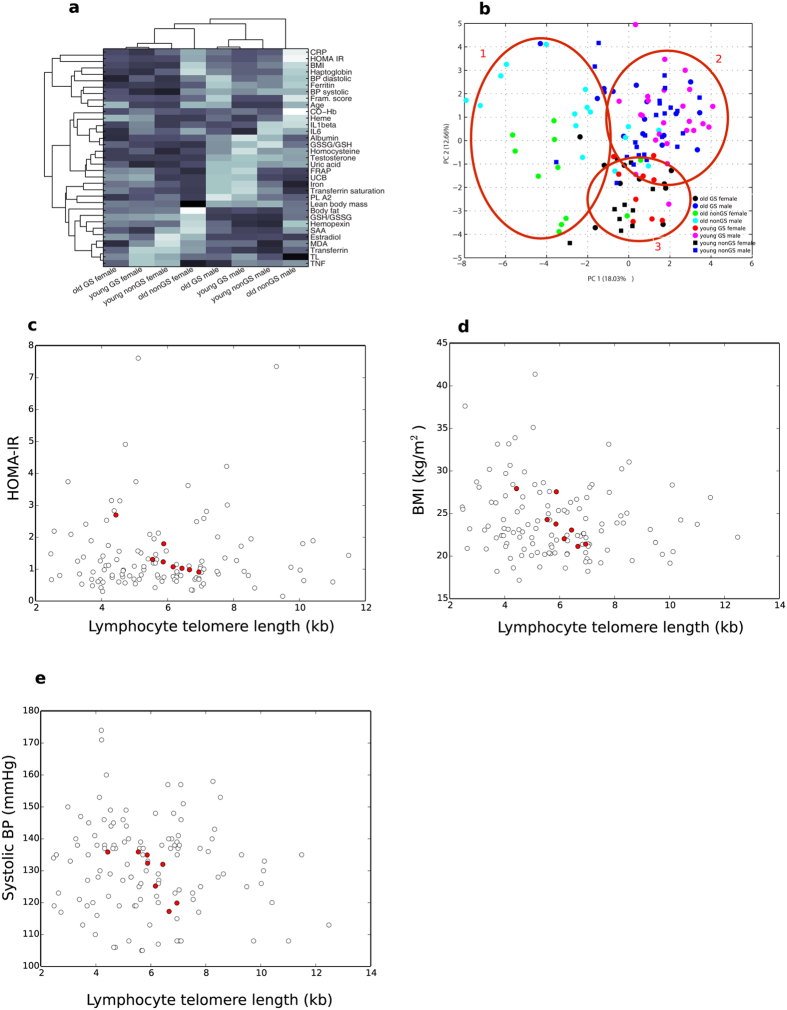
COVAIN analyses revealed distinct clustering among the eight study groups, divided according to age, gender and GS phenotype.Males and females form two distinct clusters with a small distance between “young” (<35 years old) individuals and “old” (≥35 years old) GS individuals, whereas there is a clearly greater distance of “old” control subjects. (a) Heat map shows clustering of groups and contributing variables. For individual differences in variables between groups refer to supplementary Tables S1 and S2. (b) Principal components analysis contribute to formation of three distinct clusters (marked with red circles). Circle 1: old, non-GS males and females; circle 2: males, young GS and non-GS and old GS; circle 3: females, young GS and non-GS and old GS. (c) Pearson correlation between TL and HOMA-IR, white circles represent all data, P > 0.1; red circles represent group mean, r = −0.906, P = 0.002. (d) Pearson correlation between TL and systolic blood pressure, white circles represent all data, P > 0.1; red circles represent group mean, r = −0.762, P = 0.028. (e) Pearson correlation between TL and BMI, white circles represent all data, P > 0.1; red circles represent group mean, r = −0.827, P = 0.011.